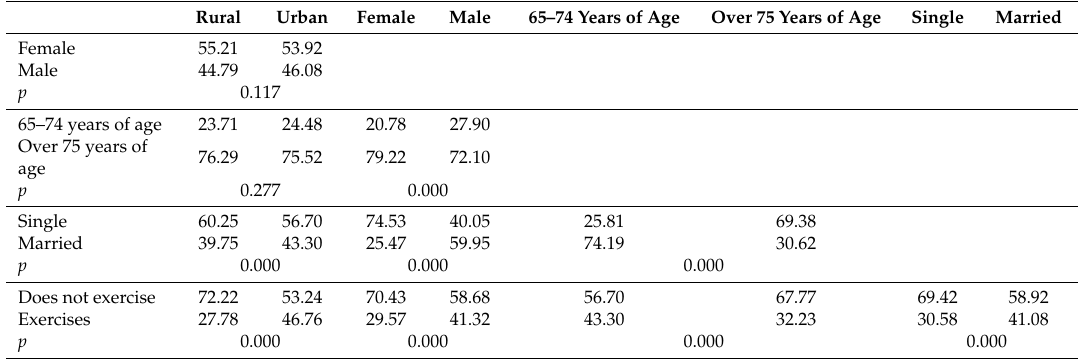
Table 6. Interaction analysis between two